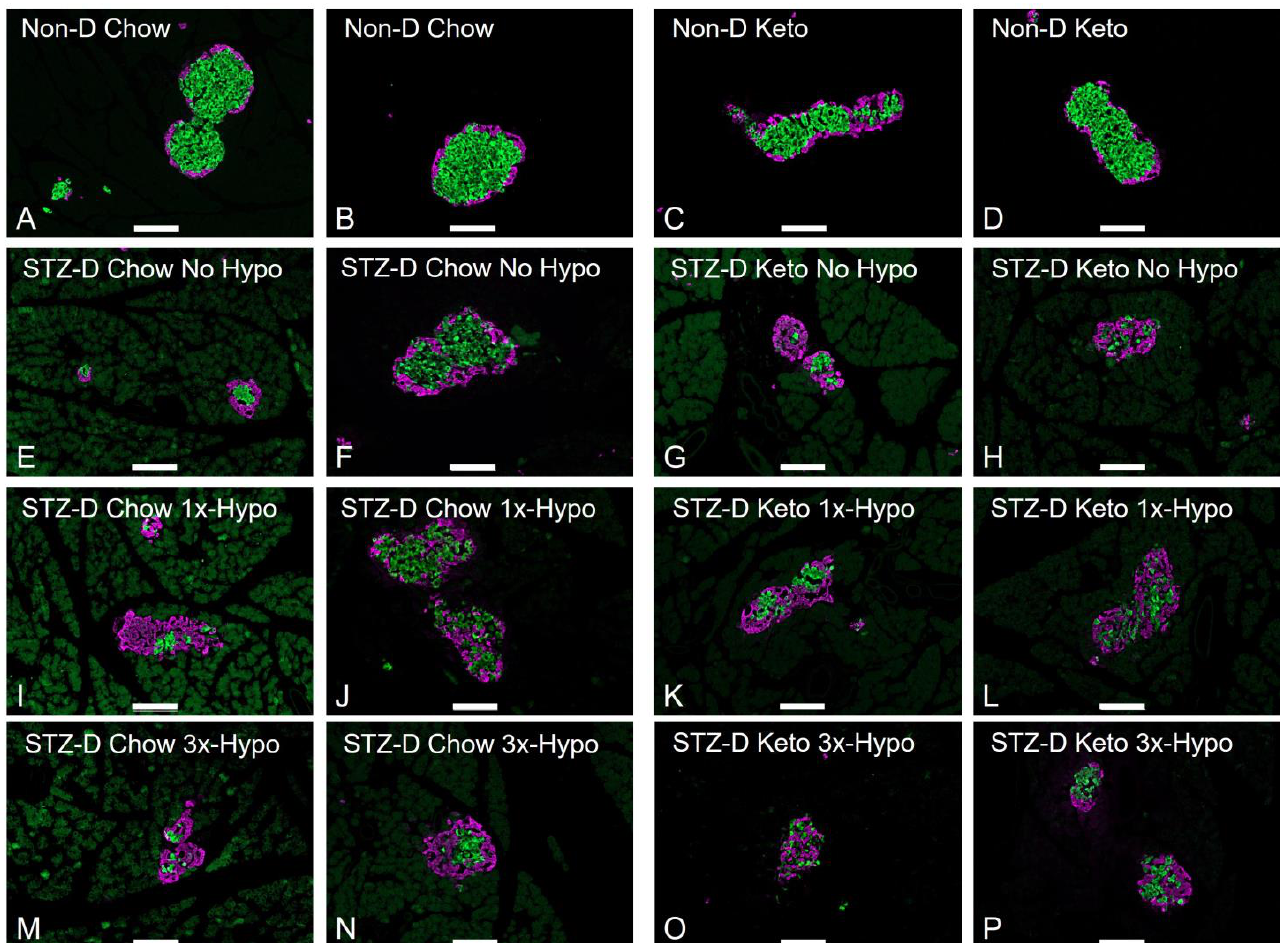
Figure 3. Changes in pancreatic islet morphology in STZ-injected rats. 5-µm sections of the pancreas were stained for insulin (green) and glucagon (purple); representative images are shown (scale bar 100 µm). ( A,B ) Non-diabetic chow-fed control; ( C,D ) Non-diabetic keto-fed control; ( E,F ) STZ-treated Chow No Hypo control; ( G,H ) STZ-treated Keto No Hypo Control; ( I,J ) STZ-treated Chow single hypoglycemia; ( K,L ) STZ-treated Keto single hypoglycemia; ( M,N ) STZ-diabetic Chow recurrent hypoglycemia; ( O,P ) STZ-diabetic Keto recurrent hypoglycemia.